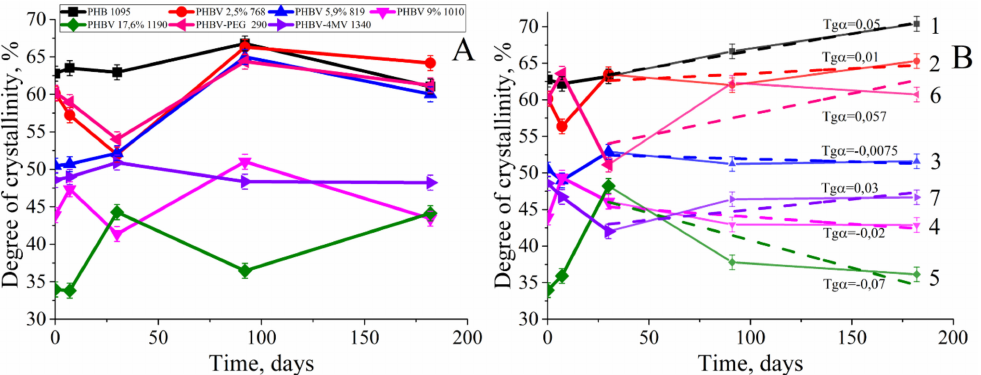
Figure 5. The change in the crystallinity of PHB, PHBV (with a di ff erent molar content of HV), PHB-4MV, PHBV-PEG films during hydrolytic ( A ) and enzymatic degradation ( B ) for 6 months: 1 – PHB 1095, 2 – PHBV 2.5% 768, 3 – PHBV 5.9% 819, 4 – PHBV 9% 1010, 5 – PHBV 17.6% 1190, 6 – PHBV-PEG 290, 7 – PHB-4MV